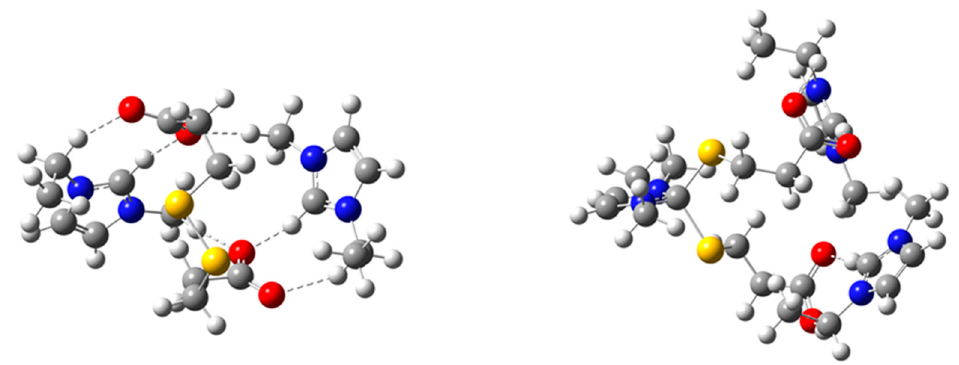
Figure 3. Left : DFT optimized structure of the minimal neutral cluster. Each carboxylate group forms two hydrogen bonds with one EMIM cation and one with the other. The –S-S- moiety presents no steric hindrance. Right : an EMIM derived carbene breaks the S-S bond leading to the first reaction intermediate (red: oxygen atom, blue: nitrogen atom, yellow: sulfur atom, grey: carbon atom, white: hydrogen atom).